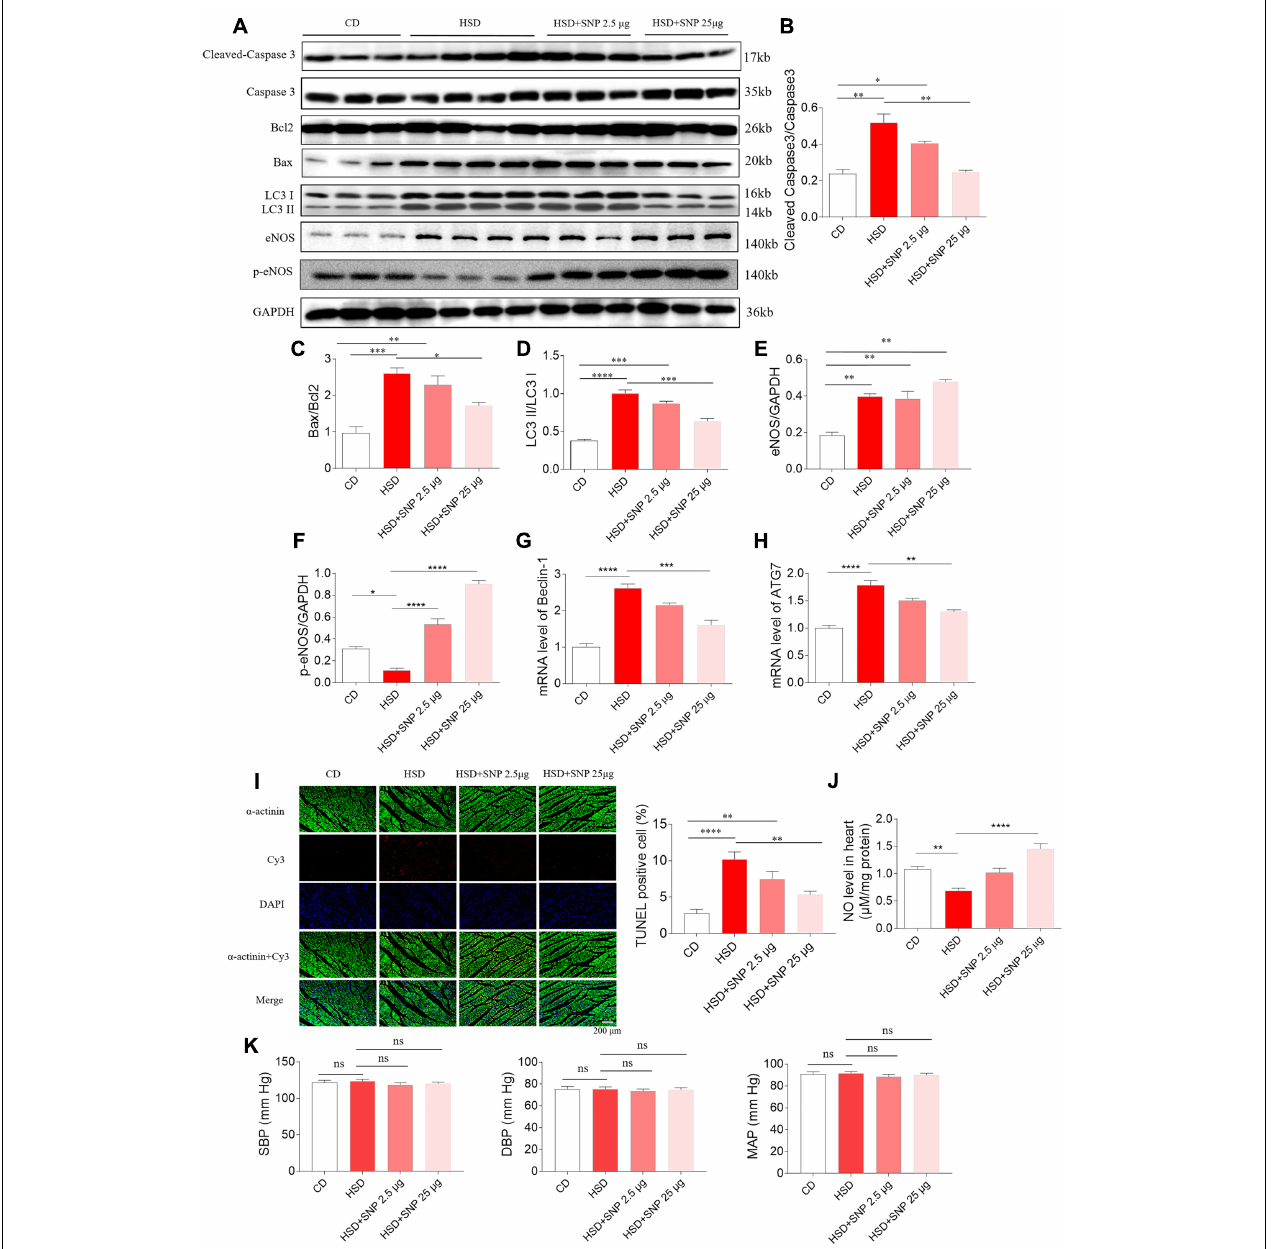
FIGURE 8 | Effects of nitric oxide donor sodium nitroprusside (SNP) on HSD-induced apoptosis and autophagy in the heart of hypertension-resistant (HR) rats. (A–H) SNP attenuated the increases in cleaved-caspase 3/caspase 3, Bax/Bcl2, Beclin-1, and autophagy related 7 (ATG7), and enhanced the decrease of p-endothelial nitric oxide synthase (eNOS) induced by HSD in the heart of rats. (I) The increase of TUNEL-positive cell number was attenuated by SNP (25 µ g/kg) treatment. (J) The decrease of nitric oxide (NO) in the heart of HSD rats with HR was increased by SNP administration. (K) SNP had no effects on the blood pressure of HR rats. The results are expressed as mean ± SEM. n = 6 for each group. * p < 0.05, ** p < 0.01, *** p < 0.001, and **** p <